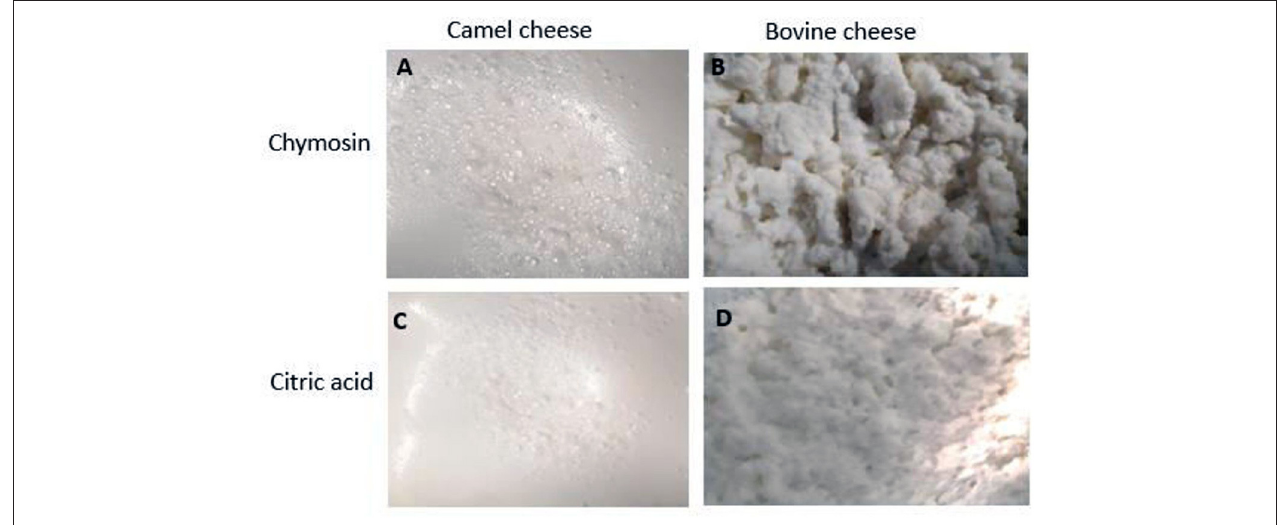
FIGURE 1 | Photographs of camel and bovine milk cheeses produced by using chymosin (50 IMCU/L milk) or 30%citric acid. (A) Camel milk cheese made with chymosin, (B) Bovine milk cheese made with chymosin, (C) Camel milk cheese made with citric acid, and (D) Bovine milk cheese made with citric acid.